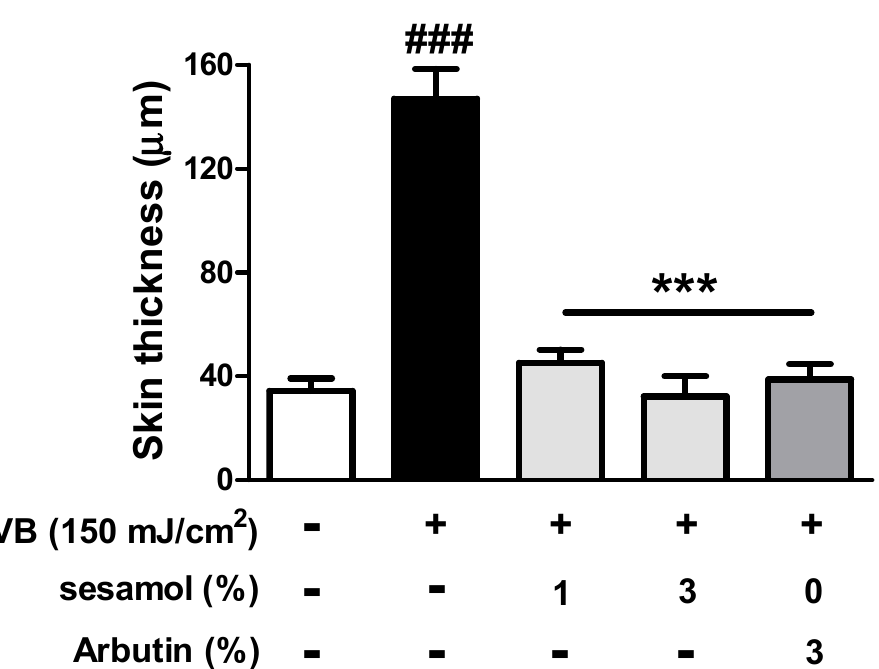
Figure 7. Effect of sesamol on UVB-irradiation-induced histopathological changes in C57BL/6 mouse ear skin. Tissue morphology was visualized through hematoxylin and eosin (H&E) staining (400X). UVB irradiation caused hyperplasia in the skin, whereas topical application of sesamol once a day to the ear skin reduced the thickness of the epidermis. (Significant difference versus control: ###, p < 0.001. Significant difference versus UVB treated group: ***, p < 0.001.).